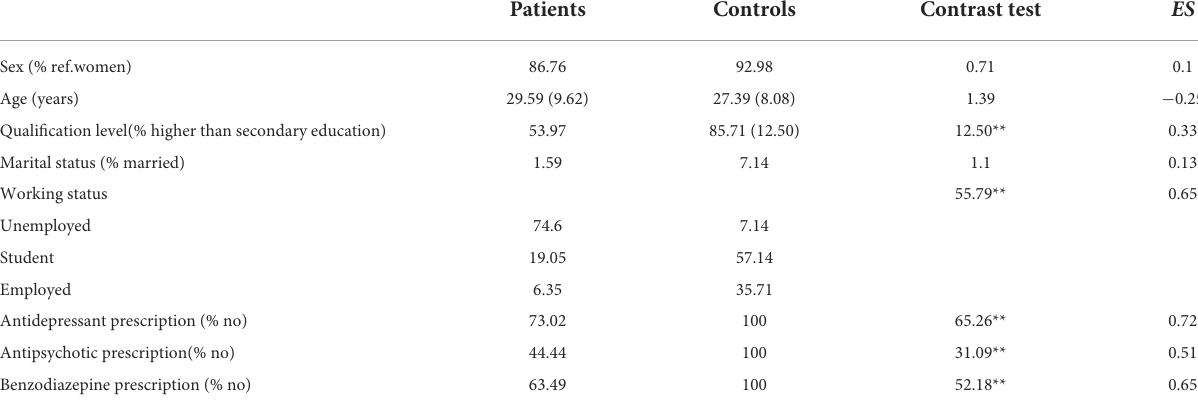
TABLE 1 Descriptive statistics according to study